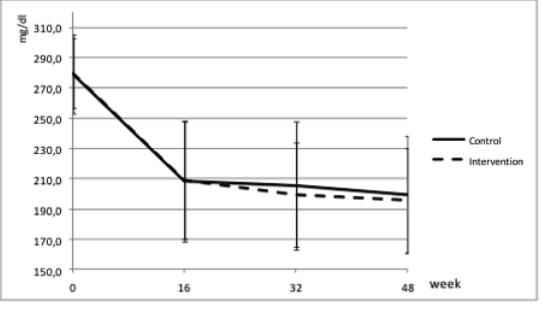
Figure 2. Changes of total cholesterol level over time, by studied